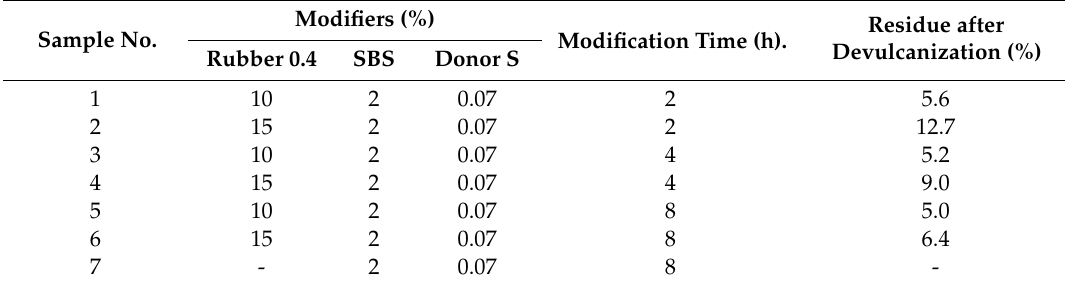
Table 2. Bitumen modified at 220 °C.